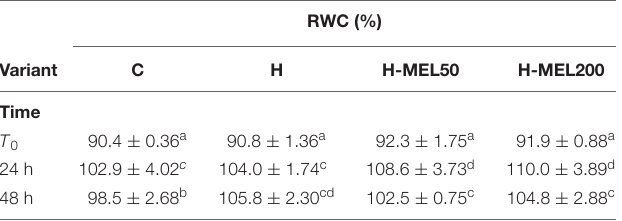
TABLE 1 | Relative water content (RWC) in leaf disks of 24-day-old pea plants grown from the control (C), hydroprimed (H), and hydroprimed with